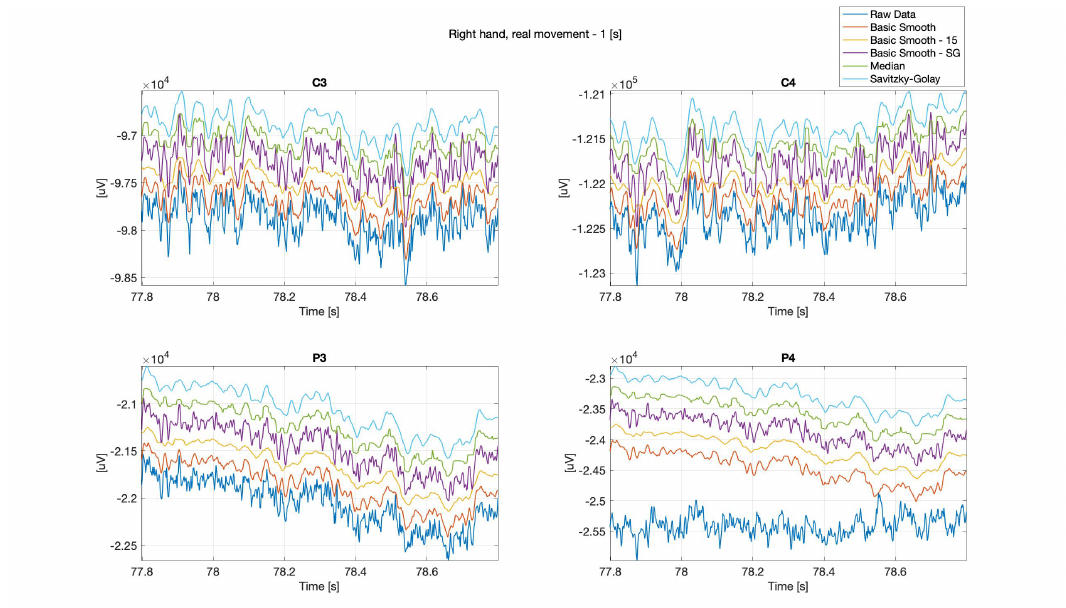
Figure 2. Right hand, real movement, C3, C4, P3 and P4